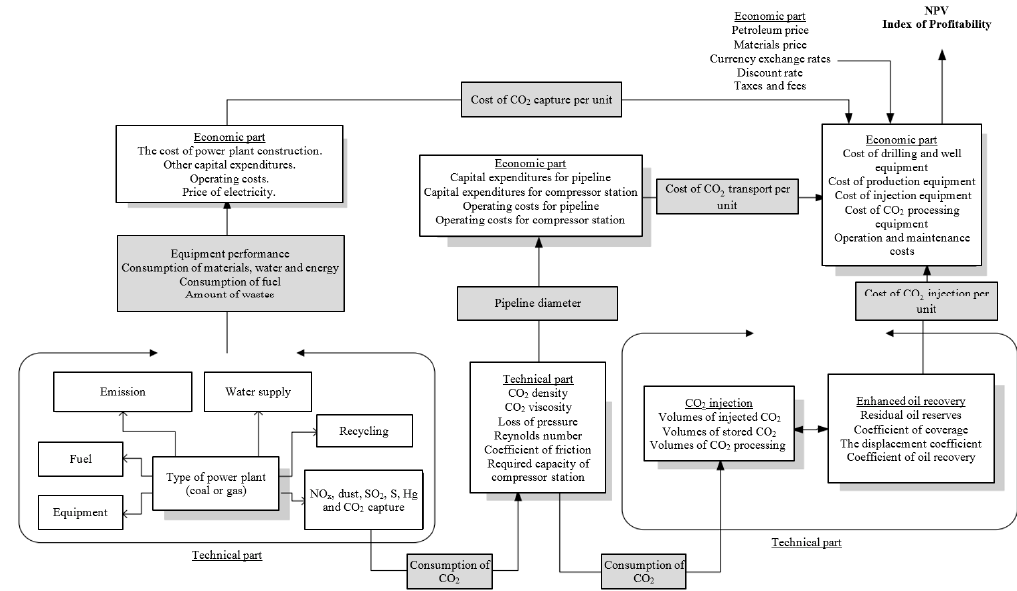
Figure 4. Proposed technical-economic model.